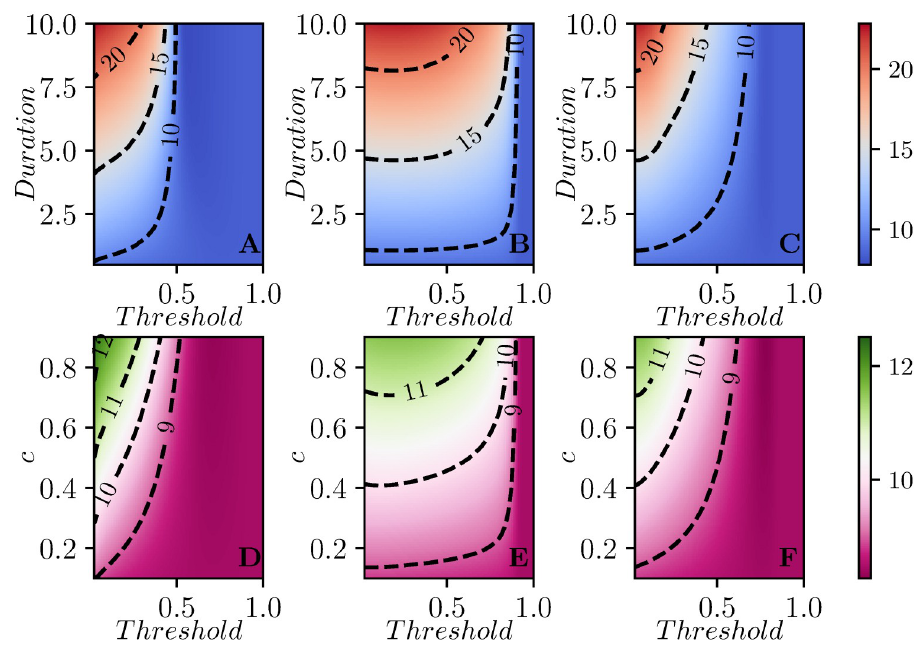
Fig 9. Contour plots of the global mean infection time, defined as T = (cid:0) simulations. In terms of control strategies and parameter values have the same setup as in Figs 7 and 5 are used.